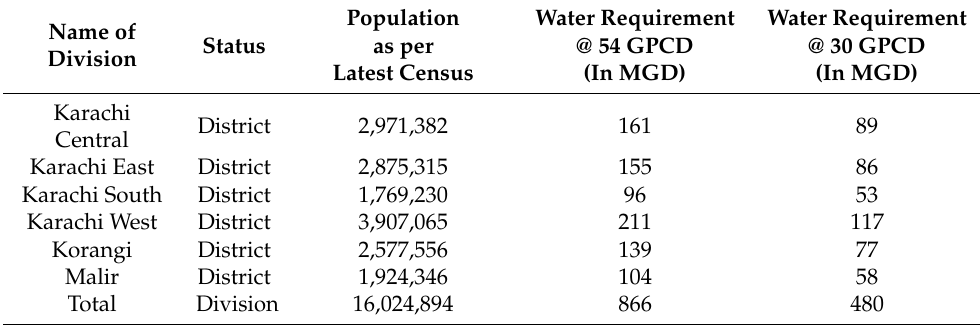
Table 2. Population and water requirements for various districts.